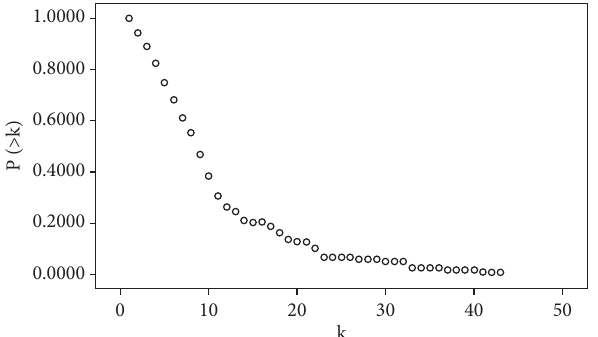
Figure 4: The cumulative